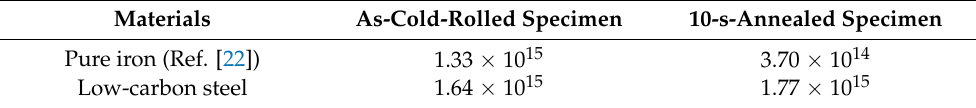
Figure 3. ( a ) Image quality and ( b ) kernel average misorientation maps of specimens annealed at 723 K for 15 s ( α R : recrystallized ferrite grain; α NR : nonrecrystallized ferrite grain). Table 1. Dislocation densities of cold-rolled and 10-s-annealed specimens.